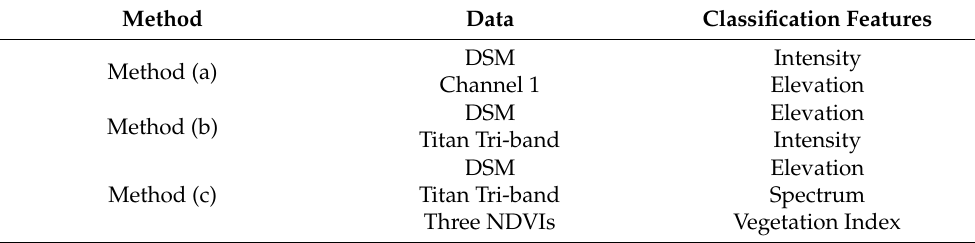
Table 3. Three method